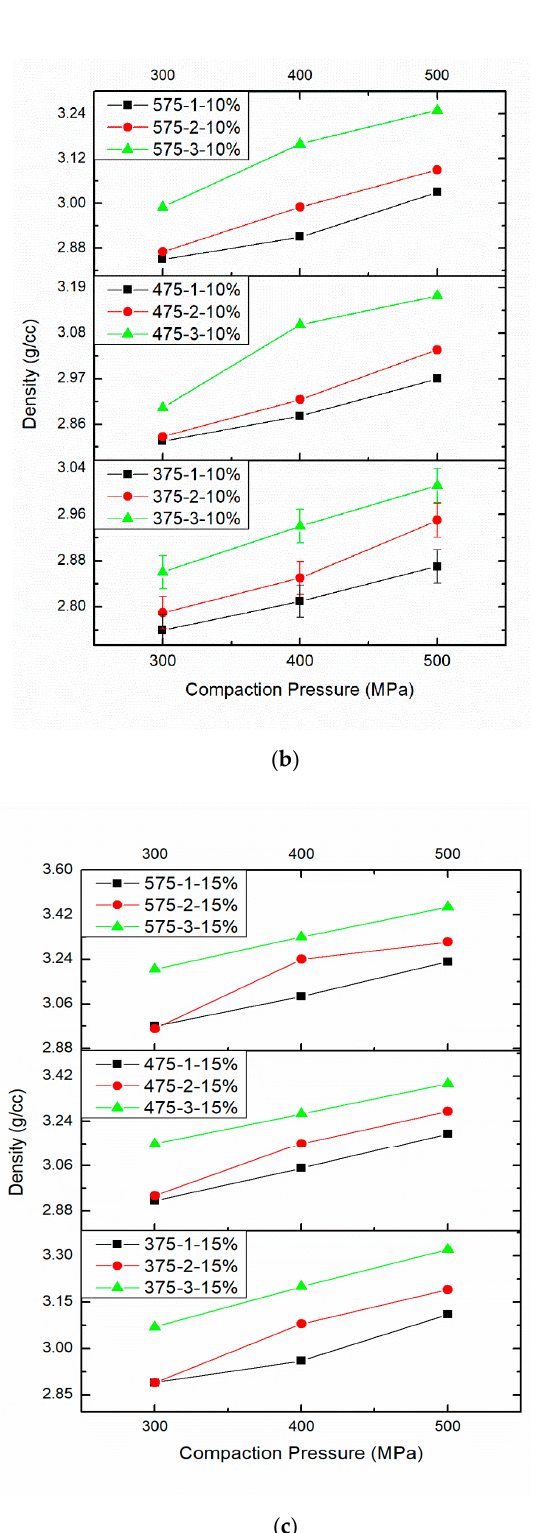
Figure 7. ( a ). Effect of different compaction pressure (300, 400, and 500 MPa), different sintering time (1, 2, and 3 h), sintering temperature (375 ◦ C, 475 ◦ C, and 575 ◦ C), and 5 wt%.B 4 C on density. ( b ) Effect of different compaction pressure (300, 400, and 500 MPa), different sintering time (1, 2, and 3 h), sintering temperature (375 ◦ C, 475 ◦ C, and 575 ◦ C), and 10wt%.B 4 C on density. ( c ) Effect of different compaction pressure (300, 400, and 500 MPa), different sintering time (1, 2, and 3 h), sintering temperature (375 ◦ C, 475 ◦ C, and 575 ◦ C) and 15 wt%.B 4 C on